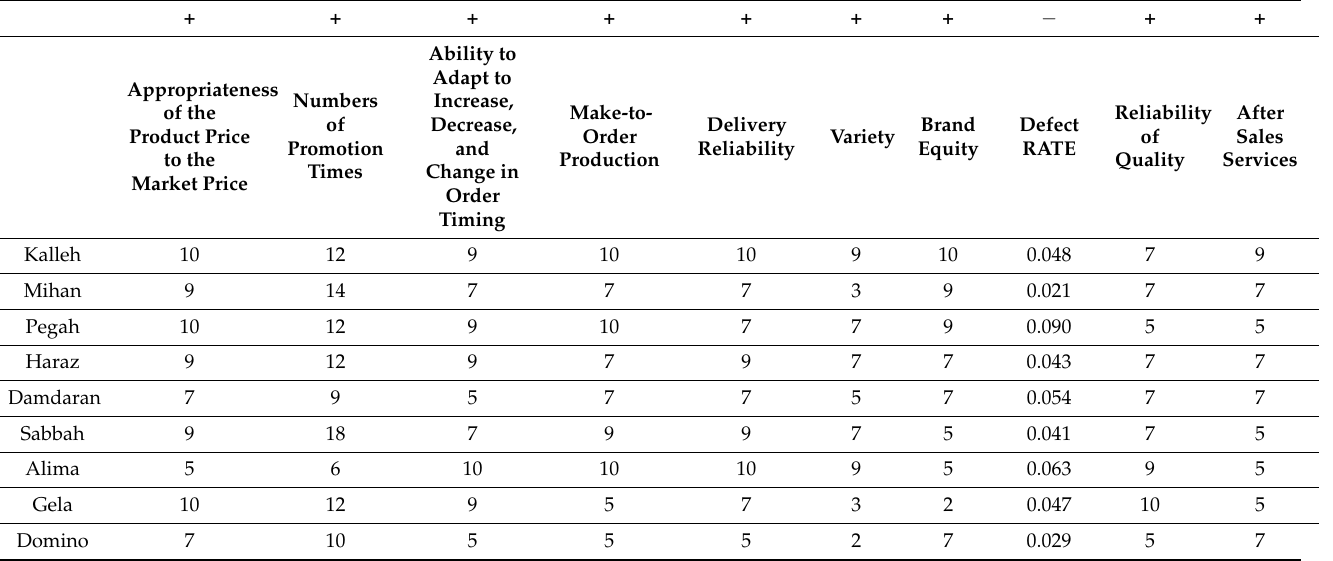
Table 6. Supplier evaluation decision matrix.